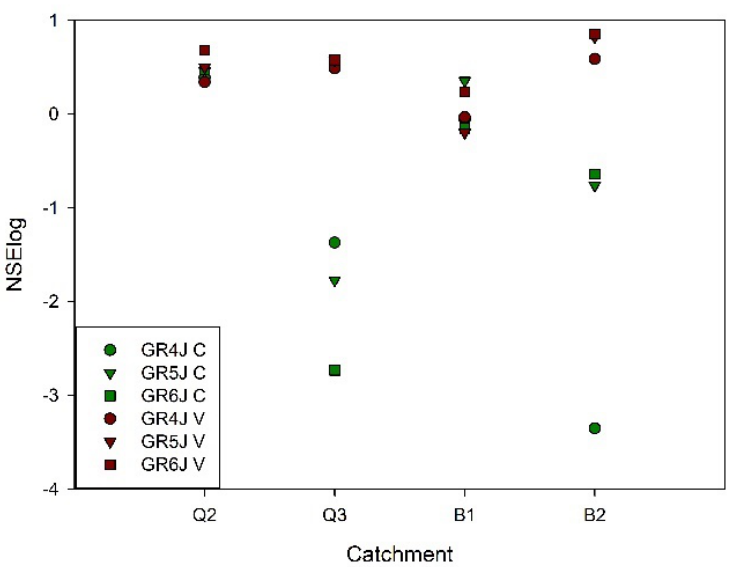
Figure 7. Streamflow simulation efficiency for models GR4J, GR5J and GR6J for summer flows in catchments Q2, Q3, BLQ1 and BLQ2 using NSElog criteria for calibration (C) and validation period (V).